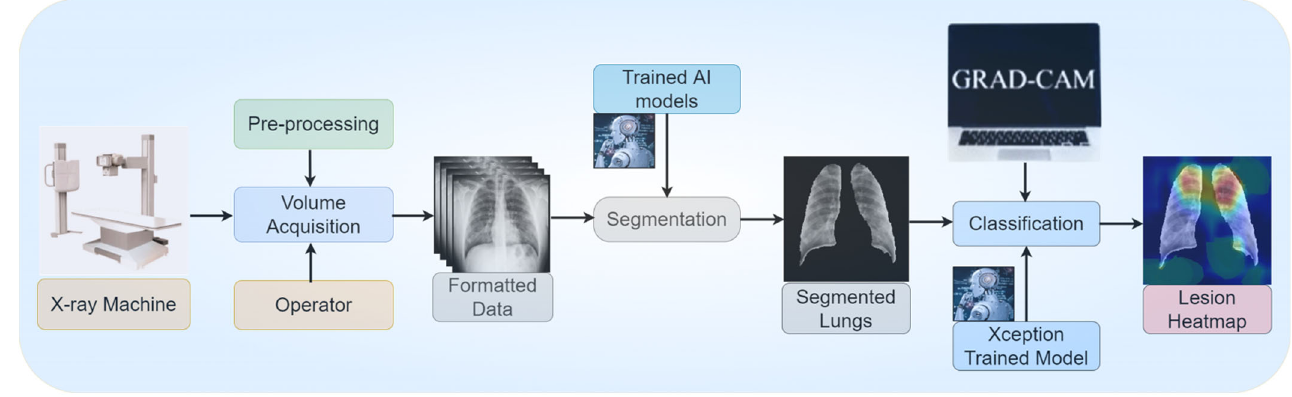
Figure 23. Heatmap generation using the Grad ‐ CAM and the Xception ‐ based classifier.